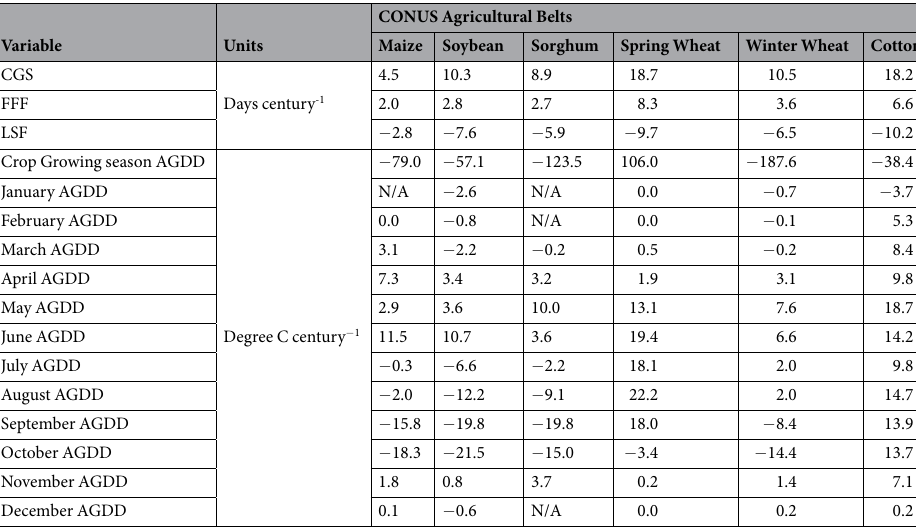
Table 1. Trends in agroclimate indices for the major CONUS agricultural belts. Cells with N/A indicate that a trend could not be computed due to zero heat accumulation in those